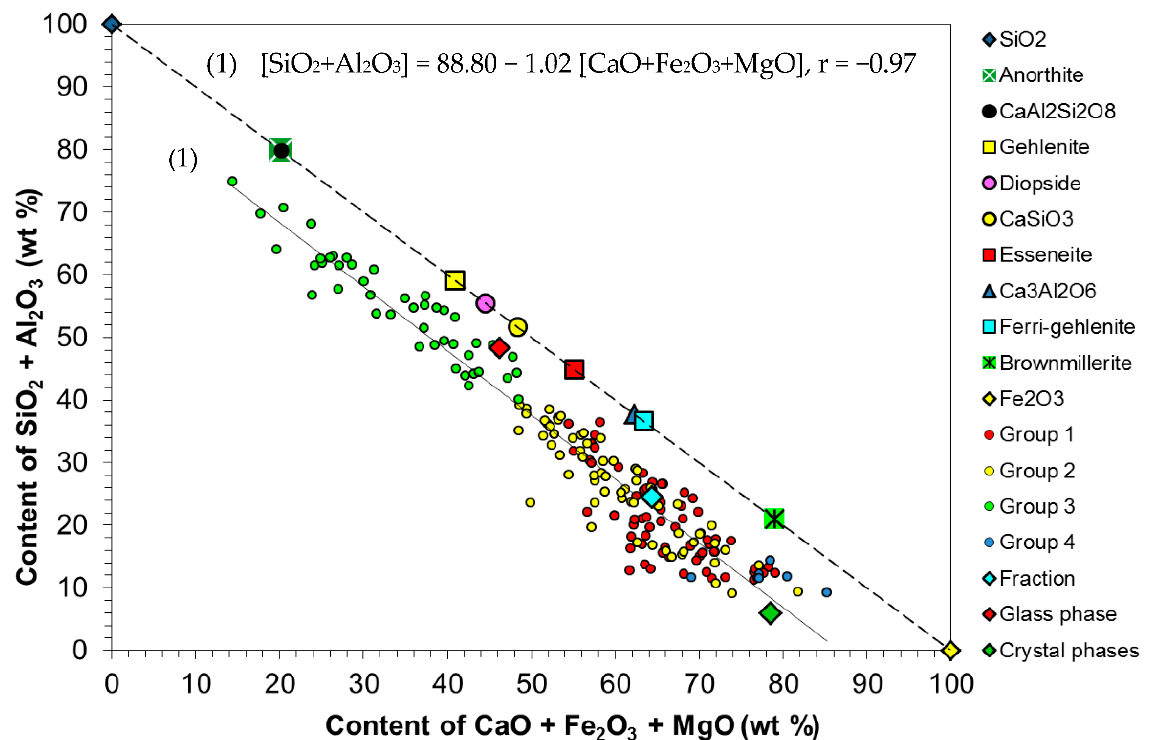
Figure 3. The (SiO 2 + Al 2 O 3 ) content as a function of the (CaO + Fe 2 O 3 + MgO) content for the fly ash fraction, glass phase, and crystal phase in it and for individual PM 1-2 microspheres from this fraction. Compositions of dehydroxylated minerals and compounds correspond to their stoichiometric formula.